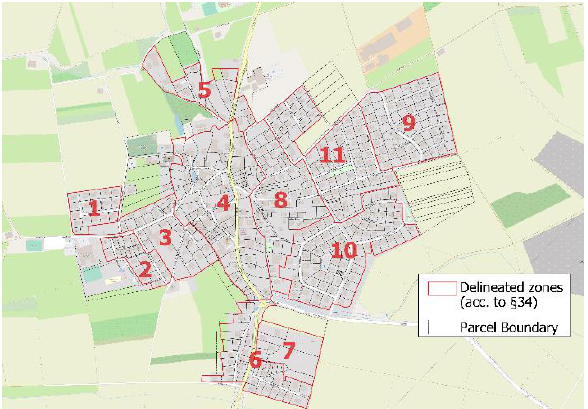
Figure 4 : Zone Delineation of Eggingen